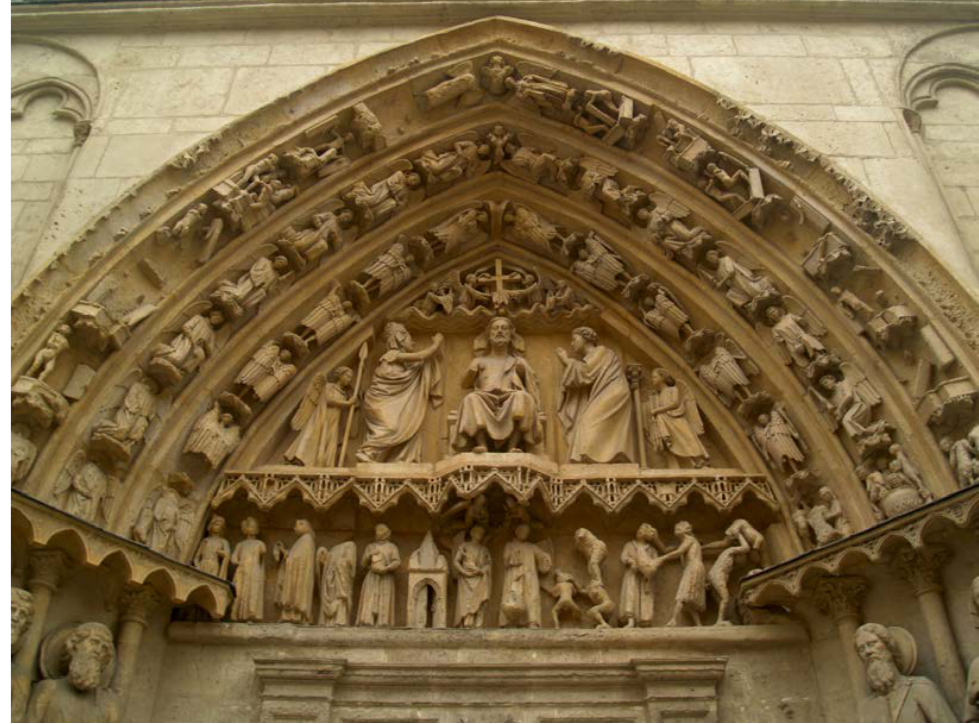
Figure 2. Tympanum of the Coroneria Portico, c. 1245–1257. North façade of the Burgos Cathedral. Hans Memling in The Last Judgement , c. 1466–73 from the National Museum of Gdańsk in Poland (Figure 3), offers a highly complex representation of the subject. In the central panel, the Pantocrator, flanked by the twelve seated apostles, appears enthroned on a rainbow, a symbol of Heaven, and with his feet on a sphere, a symbol of the created world. In this majestic pose, Christ raises his right hand towards a lily stem, a symbol of eternal salvation. He lowers his left arm as a sign of deciding the condemnation of the reprobate, a condemnation also symbolized by the sword that levitates to the left of his head. Kneeling and with hands joined to the right of Christ (to the left of the painting), the Virgin begs the Supreme Judge for mercy, while to the left of Christ, Saint John the Baptist, also kneeling and dressed in a camel skin, shows with both hands, as Precursor, the Mes- siah. Under the leading group presided over by the Pantocrartor in Heaven, on the earthly plane, the archangel Michael, clad in armor as head of the armies of angels, weighs with his balance scale the souls of the just resurrected, who, completely naked, have emerged from their graves across the landscape. In the left wing of the triptych, to the right of the divine Judge, the blessed, received by Saint Peter in the foreground, go up to Heaven, represented by a great Gothic cathedral full of angels. In the right wing of the triptych, to the left of Christ, the convicts fall in disorder into Hell, represented by a den full of fire.